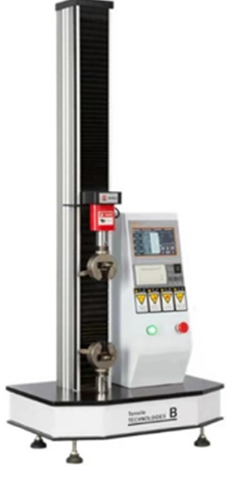
Figure 6. The tension machine. Table 1. The bonding strength of rubber to concrete.